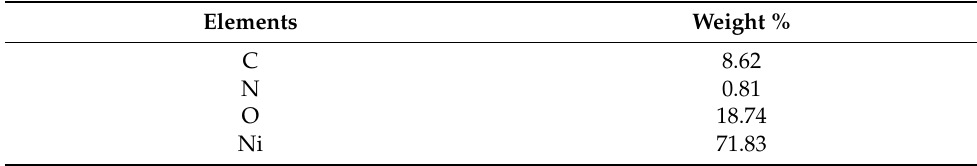
Table 1. EDX analysis of NiO/PDA nanocomposite.